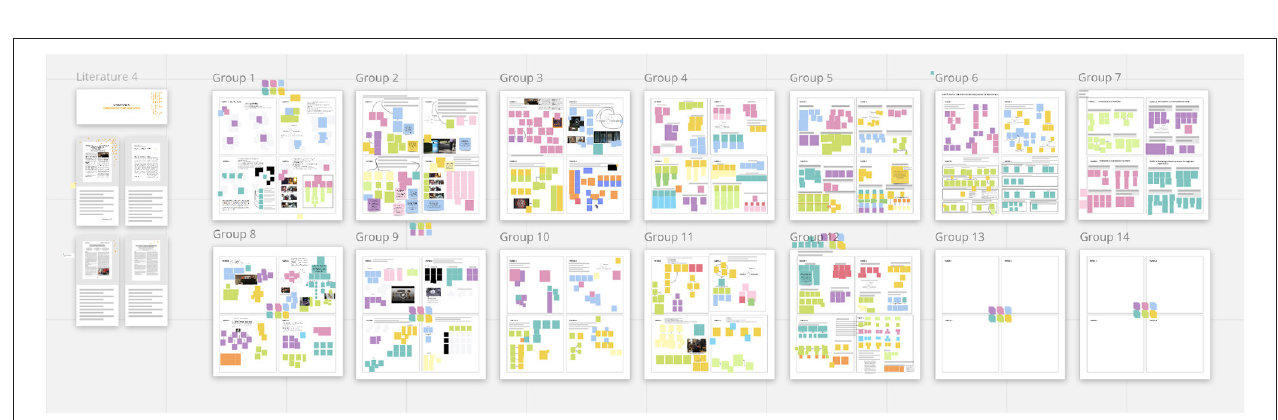
FIGURE 7 | Screenshot of a Miro board appropriated by the students when developing their Individual Projects. Two boxes can be seen marked with (A) the information given by the teacher and (B) a collection of methods and frameworks spontaneously generated by the students. The aim of this image is to give a visual impression of the content created by teachers and students, rather than provide readability. Some of the data is blurred or redacted for anonymity.